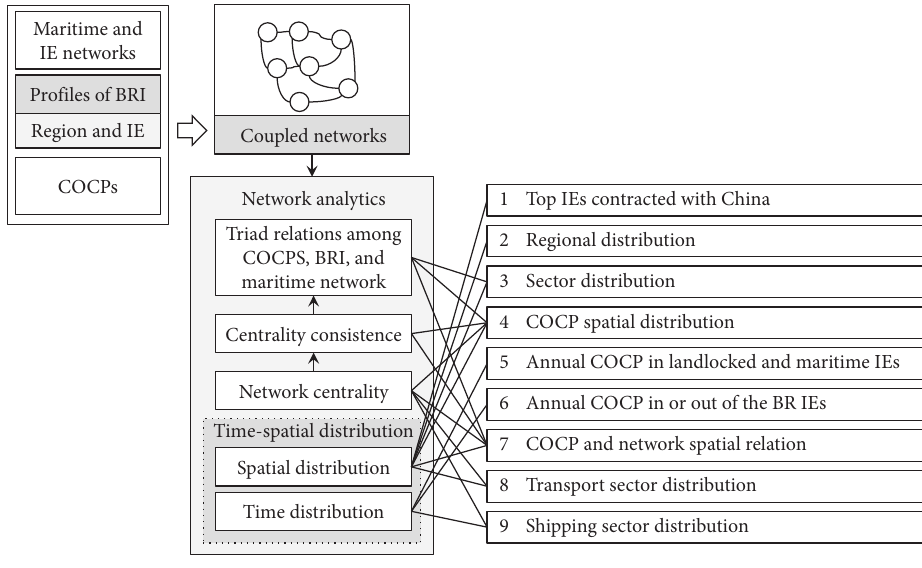
Figure 6: The systemic analyzing framework.